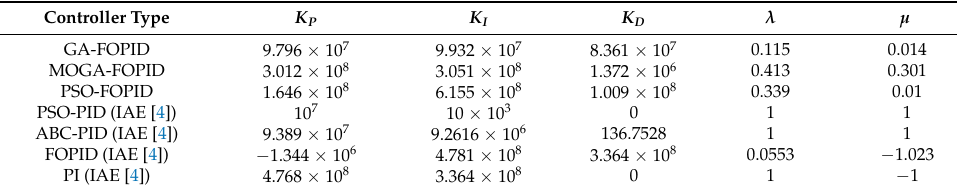
Table 5. The numerical values for the FOPID and PID